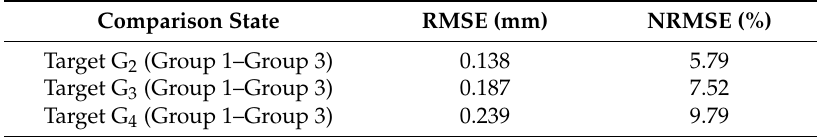
Table 3. Deformation measurement